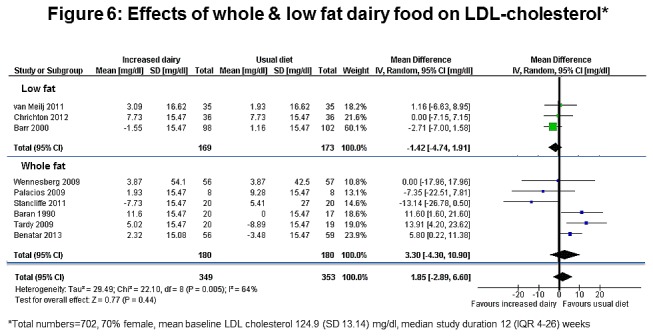
Effects of whole & low fat dairy food on LDL-cholesterol.